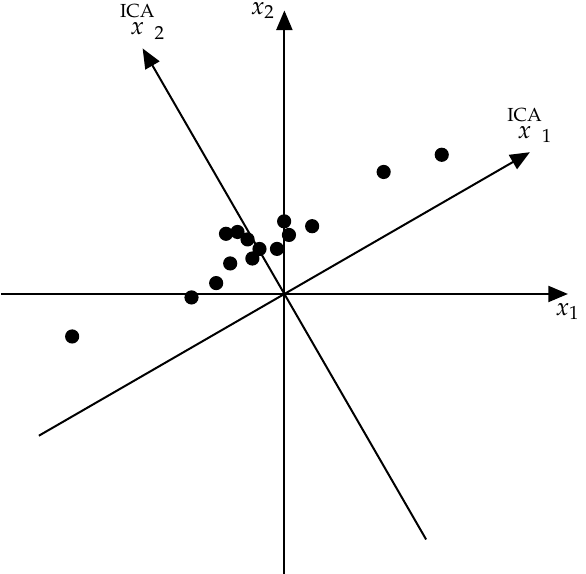
Figure 2. ICA as the transformation of the coordinate